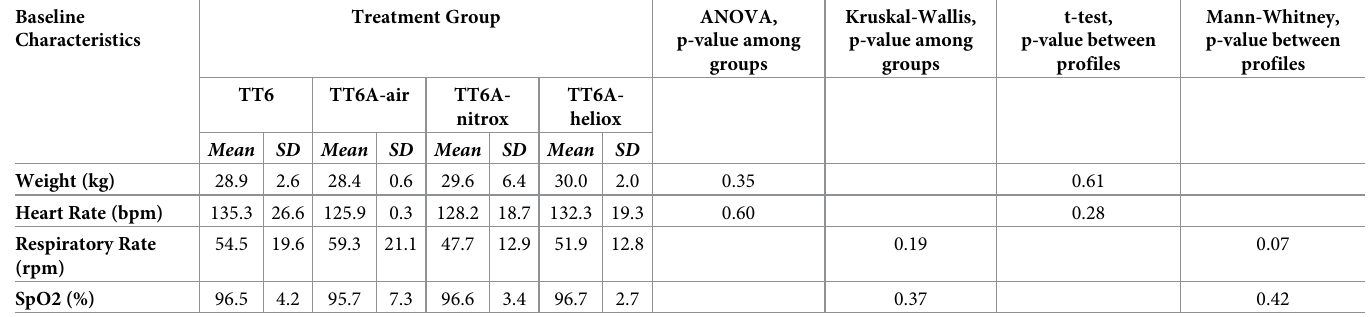
Table 3. The baseline characteristics of the animals in each of the four treatment groups with no differences in baseline characteristics among treatment groups (ANOVA, p > 0.025, Kruskal Wallis, p > 0.025) or between treatment profiles (t-test, p > 0.05, Mann-Whitney, p > 0.05). Baseline